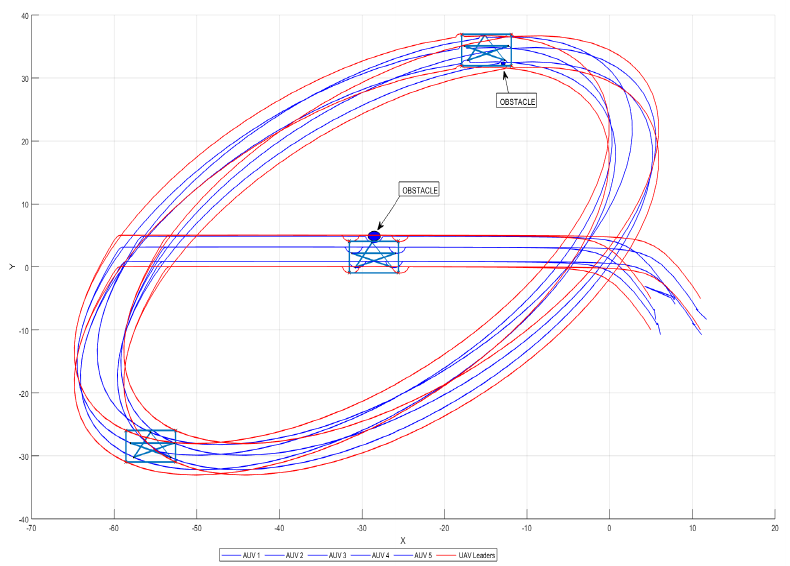
Figure 13. The containment maintenance of five AUVs in star formation within their four UAVs leaders in square formation during obstacles avoidance in 2D space.